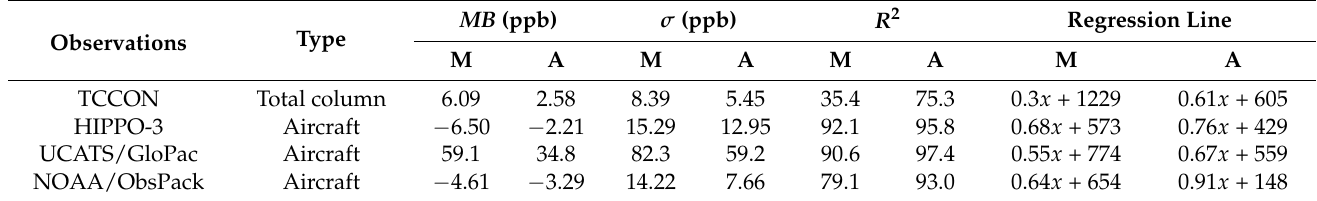
Table 2. Evaluation of model forecast (M) and analysis (A) of GOSAT assimilation against TCCON, HIPPO-3, UCATS/GloPac, and NOAA/ObsPack measurements. Comparison between mean bias ( MB ), standard deviation σ , coefficient of determination R 2 , and the linear regression line, using all measurements of each type of observation in April